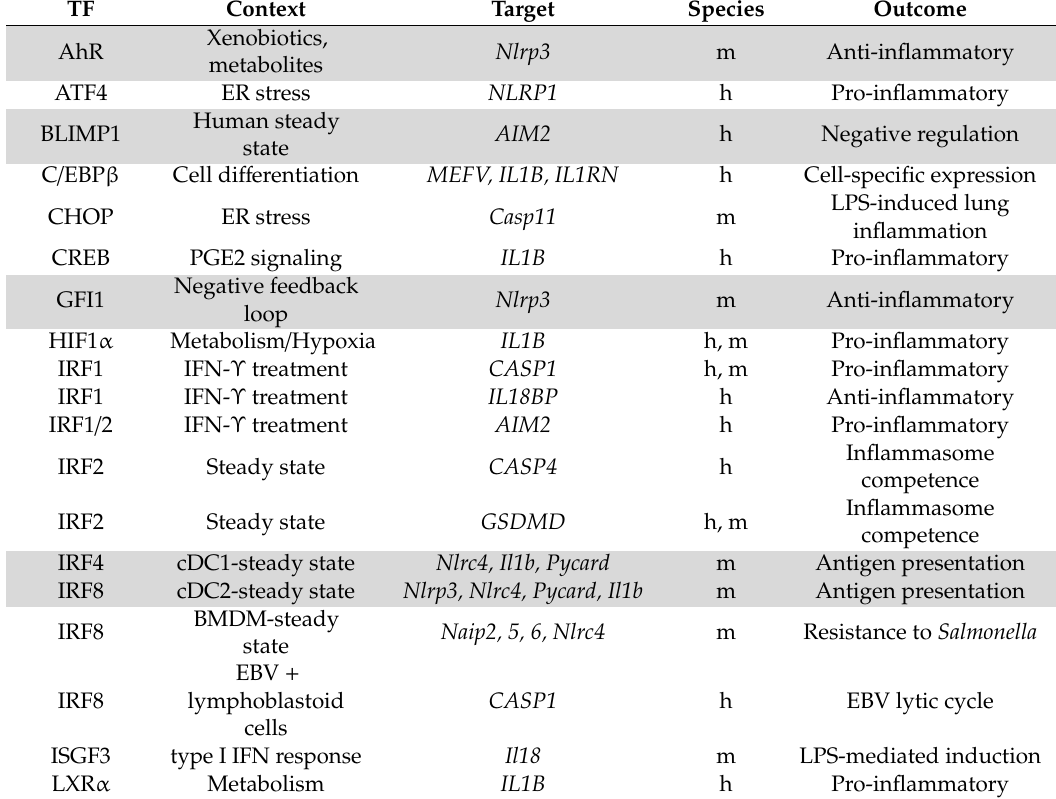
Table 1. Main Transcription Factors (TFs) Regulating Inflammasome